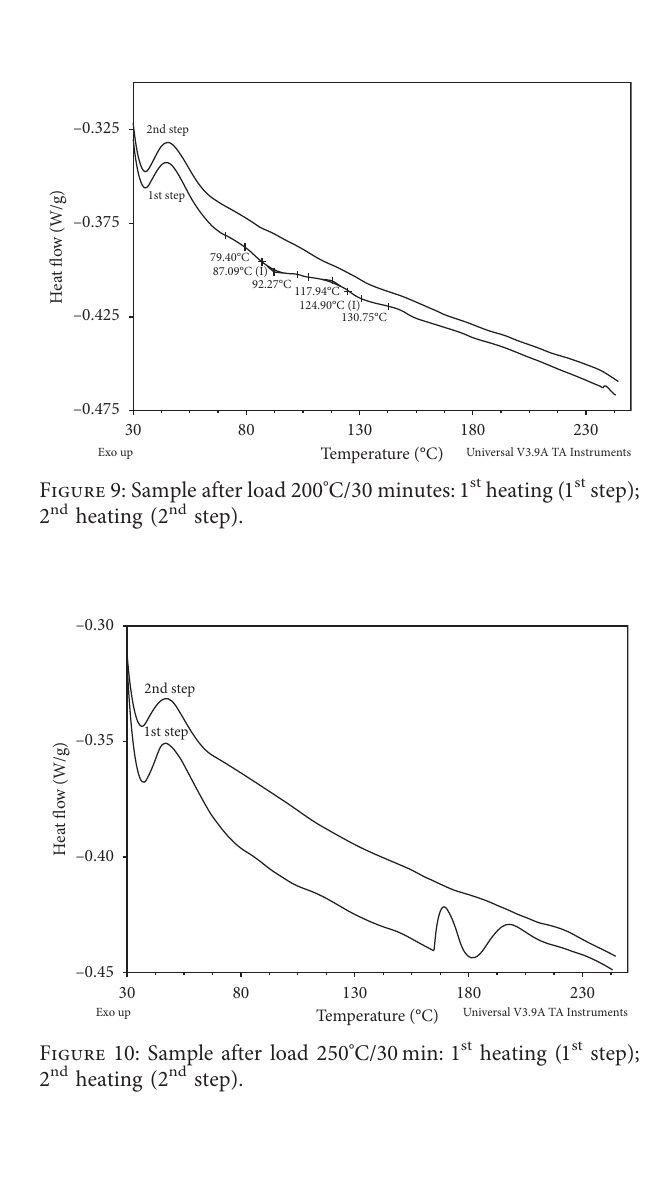
Figure 7: Thermal expansion curves for BMC depending on thermal load.